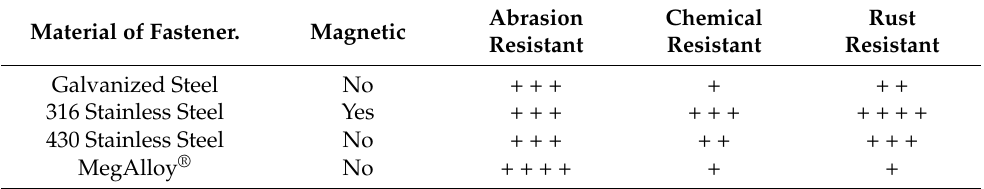
Abrasion Chemical Rust Resistant Resistant Resistant